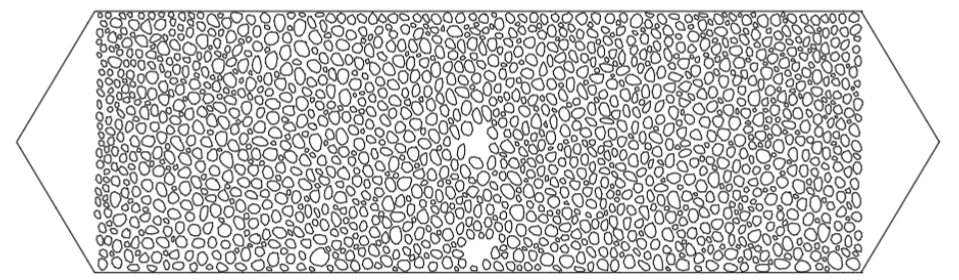
Figure 1. The design of a microfluidic model in AutoCAD.